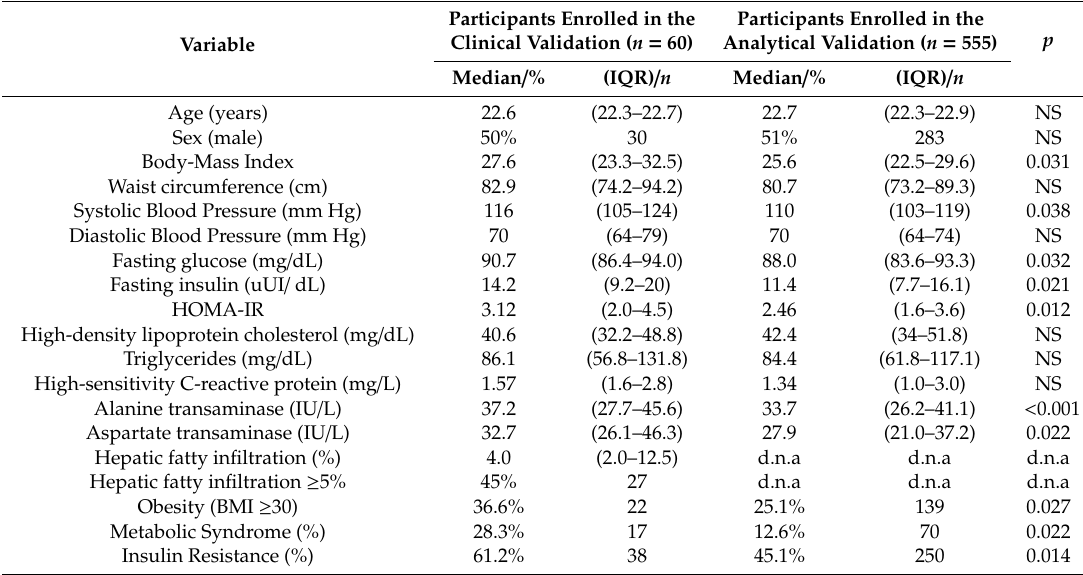
Table 1. Descriptive statistic of participants in the sample.